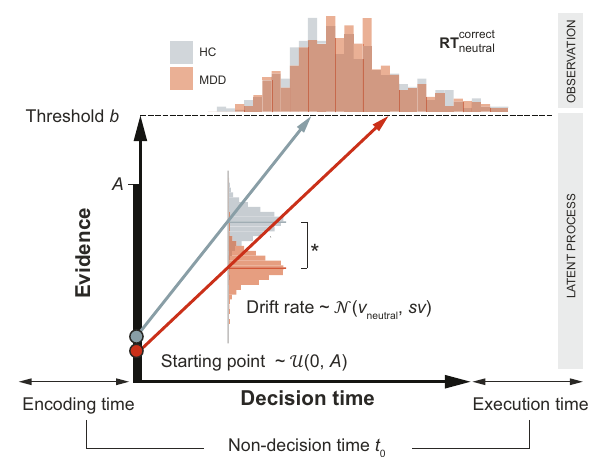
Fig. 1 Behavioral parameters. Patients exhibited slower informa- tion processing ef fi ciency represented by the lower drift rate during the face matching of neutral faces (Table